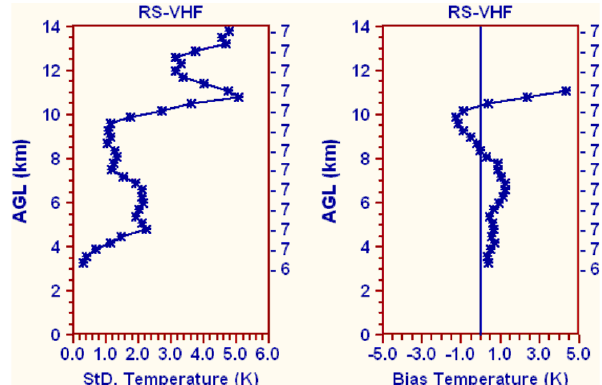
Fig. 13. Standard deviation (left) and bias (right) between temper- ature profiles provided respectively by radiosonde (RS) and VHF radar (VHF) using the vertical wind spectrum method (VHF WS) at various range gates. The columns at the right of the figures indi- cate the number of comparisons used for the